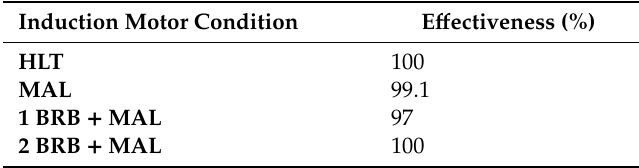
Table 2. E ff ectiveness of the proposed smart sensor on identifying the induction motor fault conditions studied here. HLT, healthy motor; BRB, broken rotor